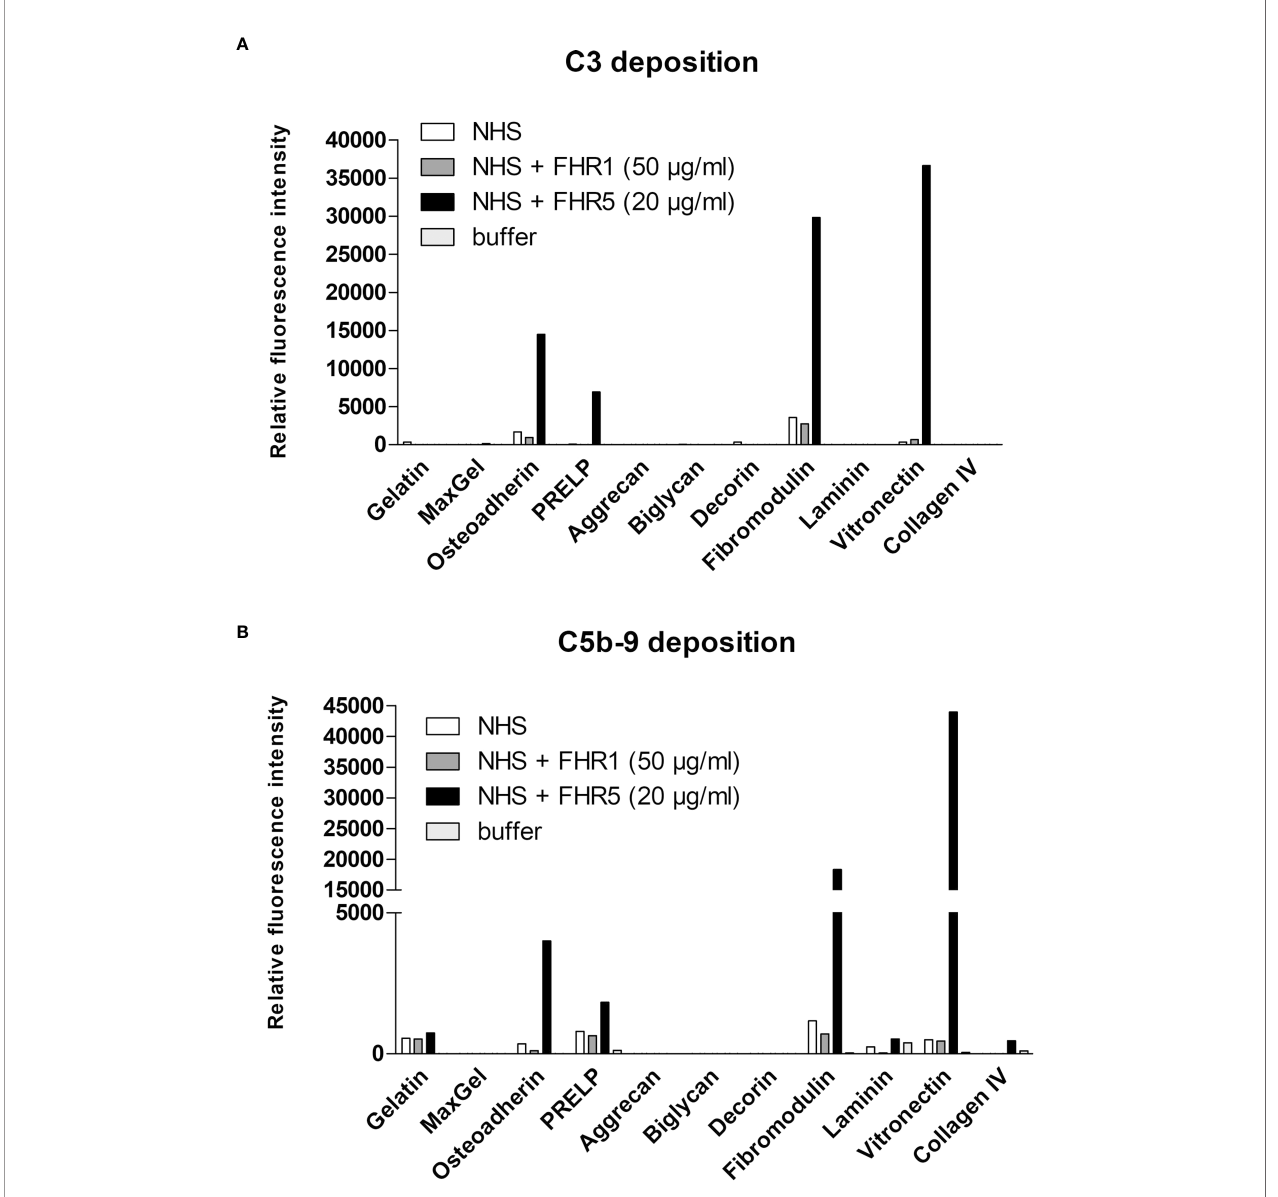
FIGURE 9 | FHR5 increases C5b-9 deposition on ECM ligands. ECM proteins were printed onto nitrocellulose-covered slides and after blocking, proteins were incubated with normal human serum (NHS) in the presence or absence of recombinant FHR1 (50 µg/ml) or FHR5 (20 µg/ml) for 1 hour at 37°C. Bound proteins were detected with polyclonal anti-C3 (A) or monoclonal anti-sC5b-9 (B) and with the corresponding secondary Ab. Data are representative of two independent